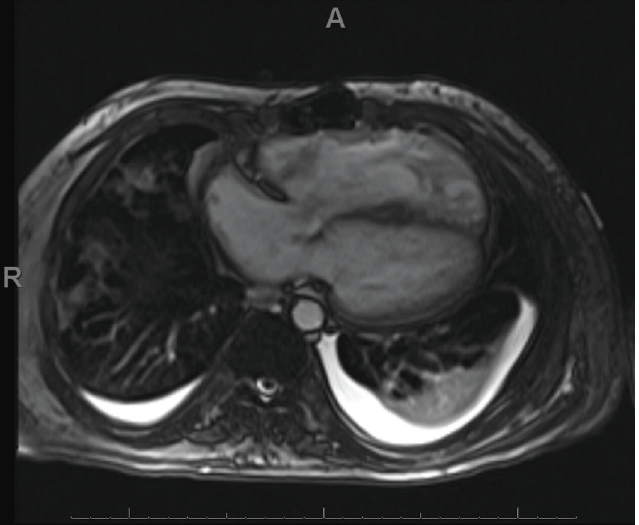
Figure 4: Cardiac magnetic resonance imaging demonstrating marked right ventricular